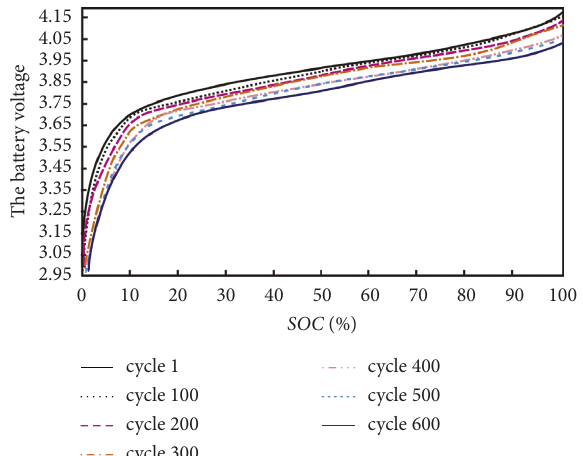
Figure 7: Corresponding curve of battery voltage and SOC after capacity modification.